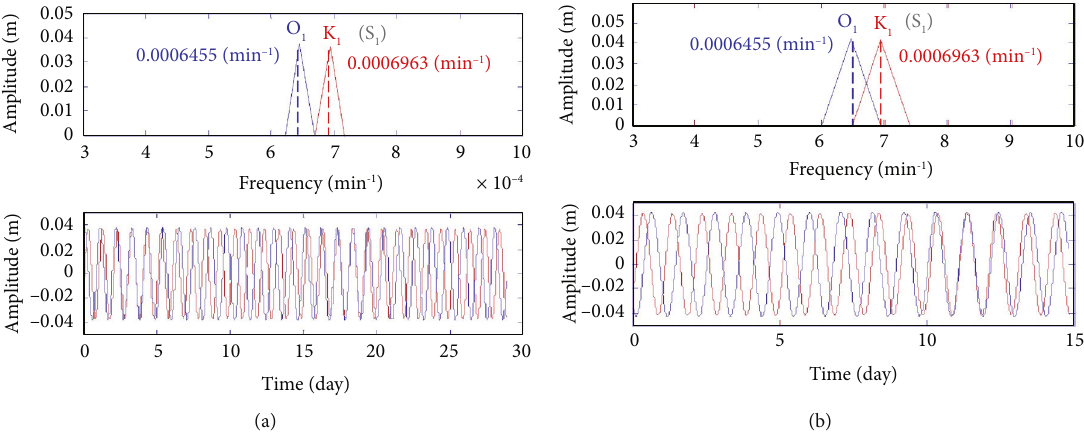
Figure 13: (a) Above: distilled O (red) tides. (b) Above: distilled O (red)